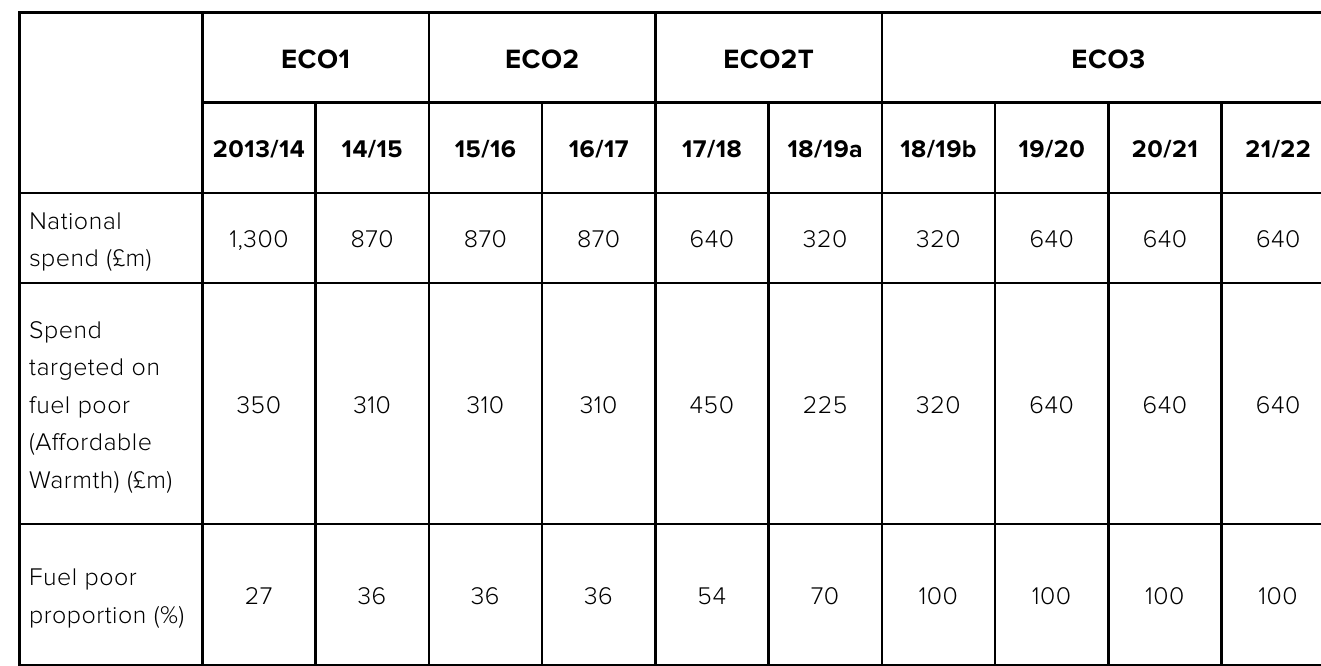
Table: Share of ECO notional spend targeted at fuel